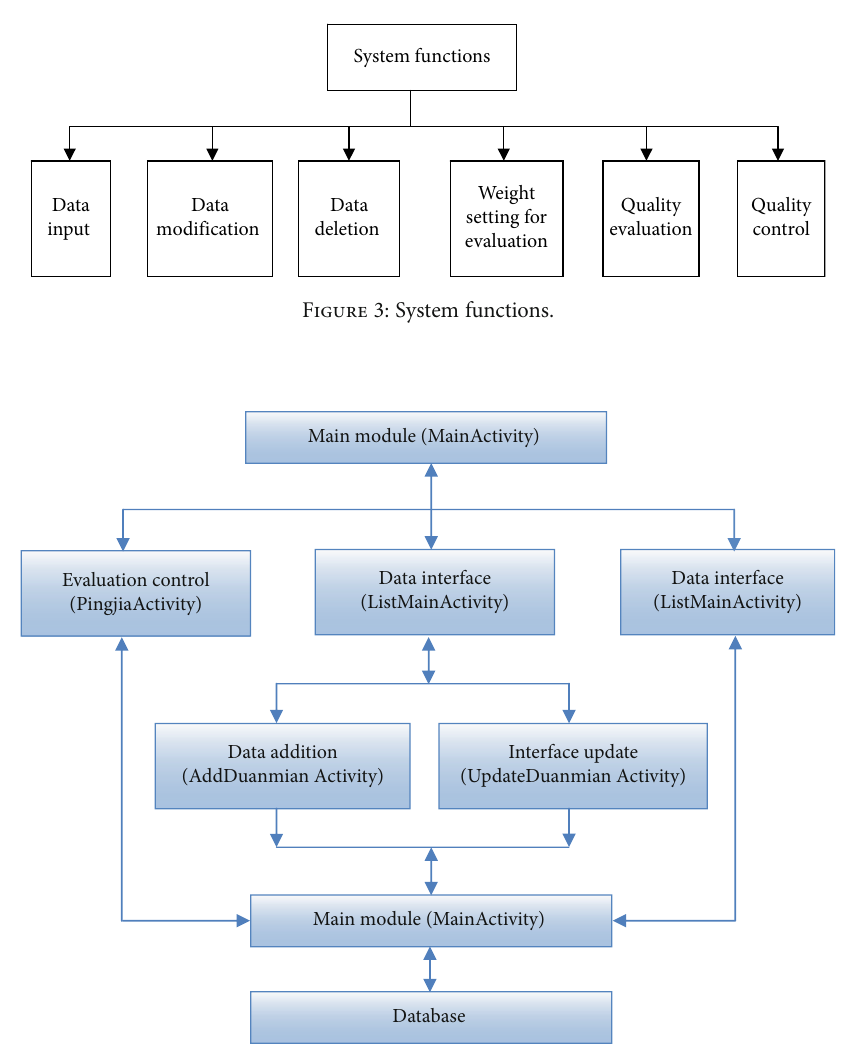
Figure 4: Modules of system